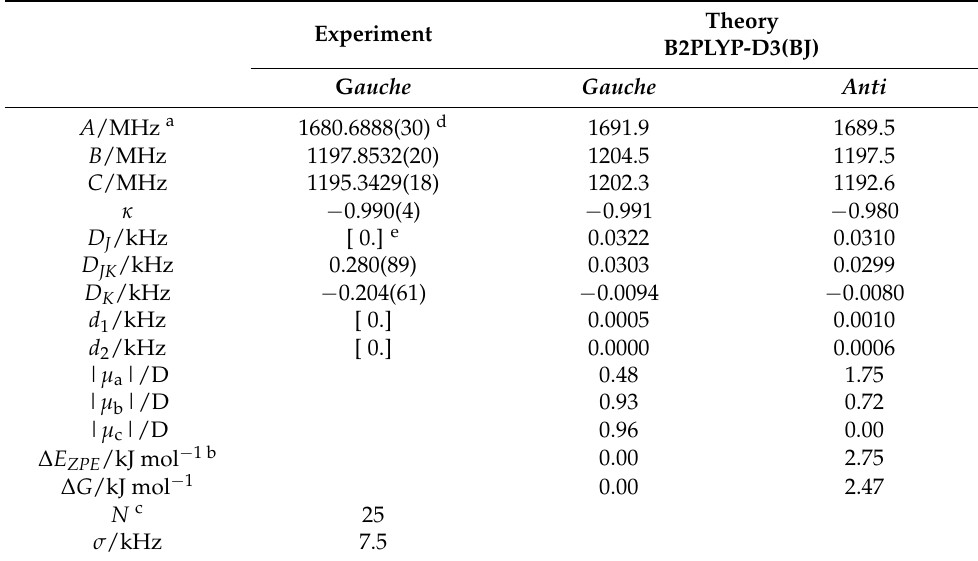
Figure 1. The gauche ( left , global minimum) and C s plane-symmetric anti ( right ) conformations of 2-adamantanol. Table 1. Rotational parameters for the 2-adamantanol monomer.